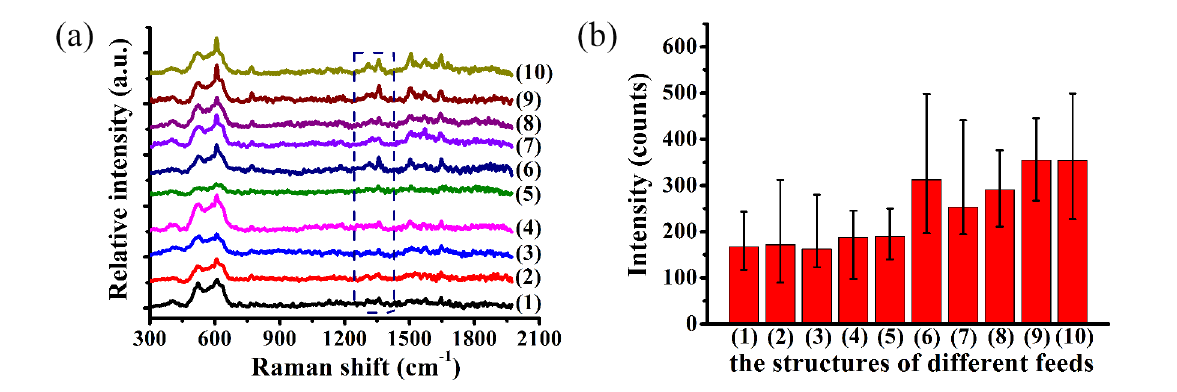
Figure 6: (a) Raman spectrum of R6G molecules at 10 − 8 mol/L with different feeds, as defined in Table 1, on Ag/Cu substrates with a corrosion time of 5 minutes. (b) Average Raman intensity of the 1362 cm − 1 peak for the structured Ag/Cu substrates with different feeds.